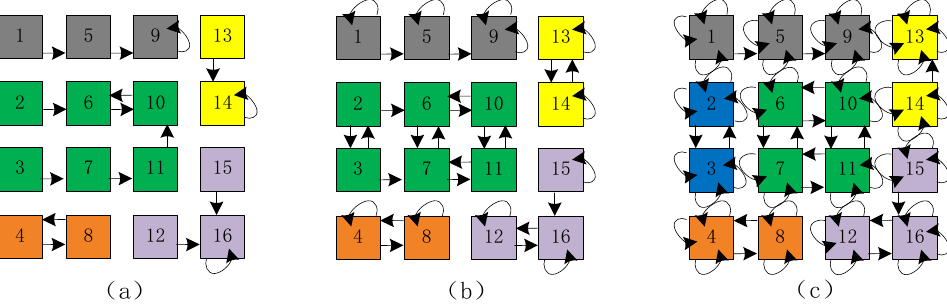
Figure 3. Three kinds of connection modes, ( a ) the one-connection mode (CM1), ( b ) the two-connection mode (CM2), and ( c ) the four-connection mode (CM4).